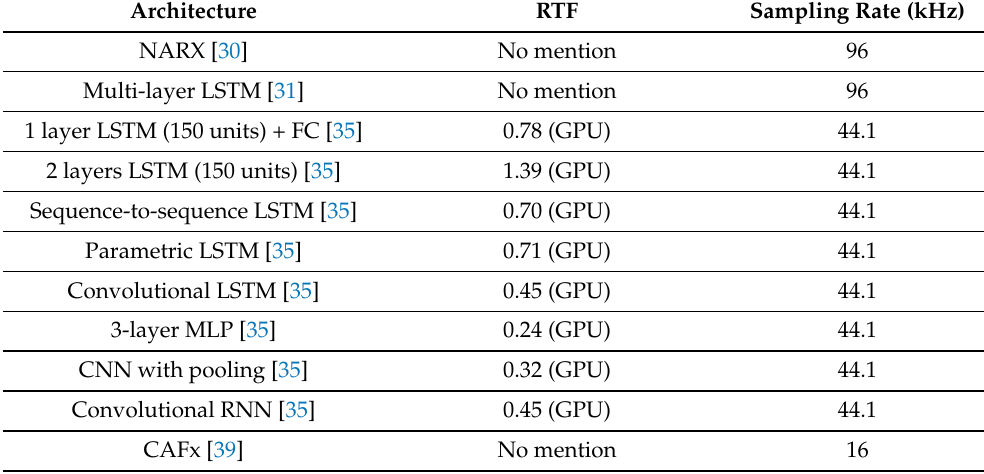
. RTF lower than 1 is required for real-time operation. RT constraint